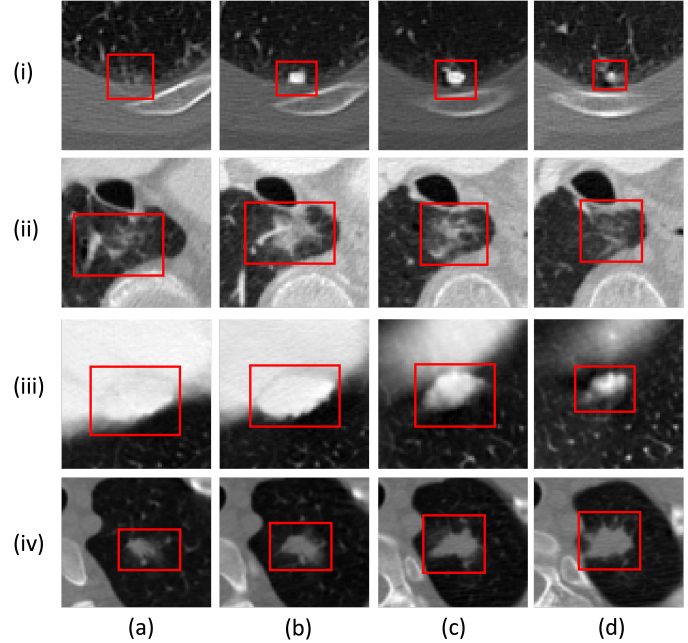
Figure 1. Illustration of different types of lung nodules. The intra-nodule diversity can be noticed from column (a) to (d), whereas inter-nodule variations are demonstrated from the row (i) to (iv).